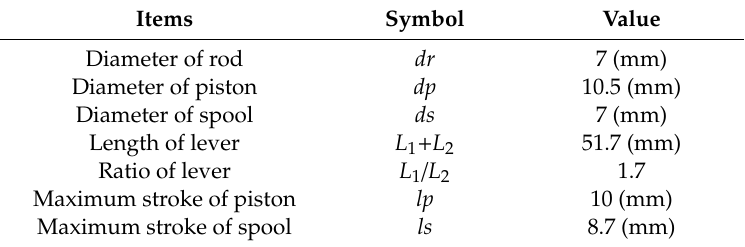
Figure 4. The design of the linear pump: ( a ) exploded view of the pump design; ( b ) prototype of the pump. Table 1. Mechanical parameters of the